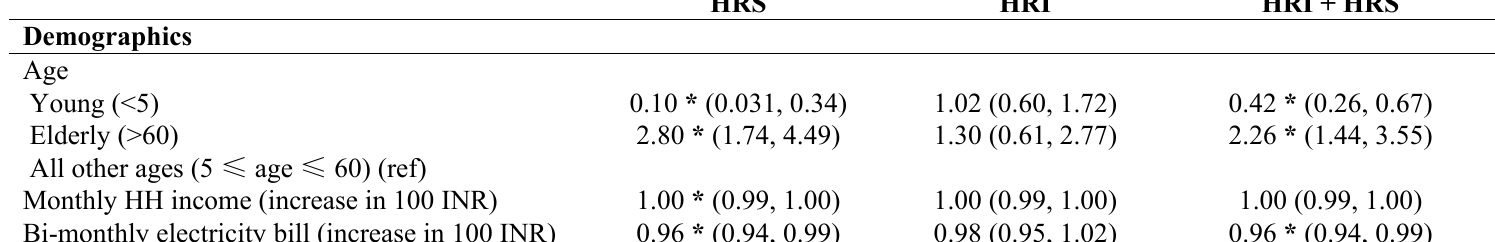
HRS HRI HRI + HRS